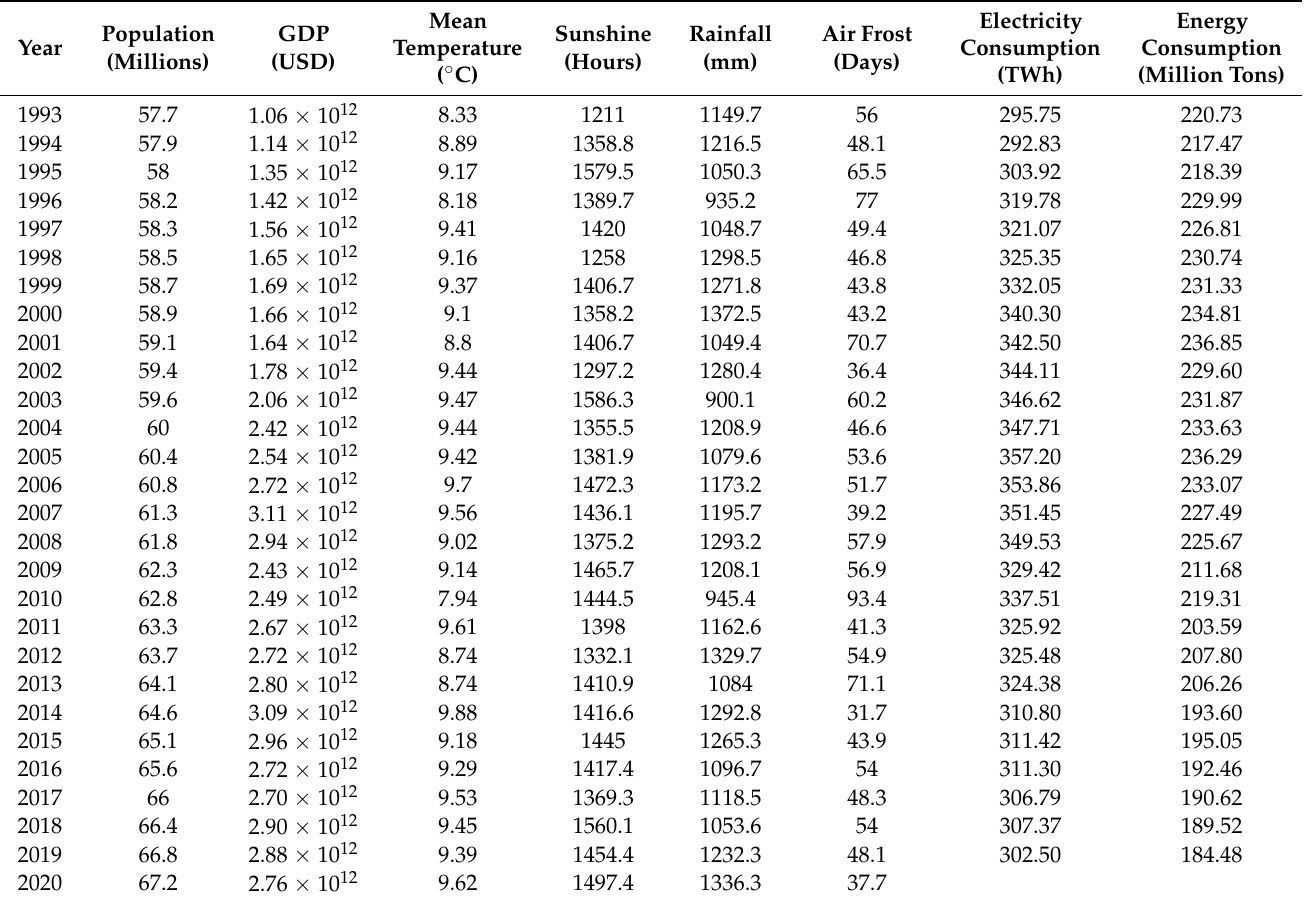
Table 2. Original data of input and output